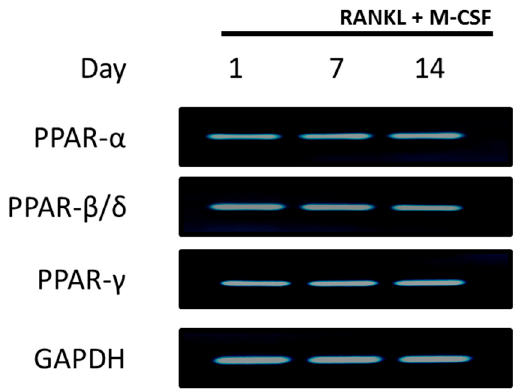
Figure 1. Peroxisome proliferator activated receptors (PPAR) expression in CD14+ monocytes. CD14+ monocytes were seeded into 24-well plates for 24 h to allow attachment. RNA was isolated for detection monocytes were seeded into 24-well plates for 24 hrs to allow attachment. RNA was isolated for of PPAR expression at days 1, 7 and 14. GAPDH served as a loading detection of PPAR expression at days 1, 7 and 14. GAPDH served as a loading control.